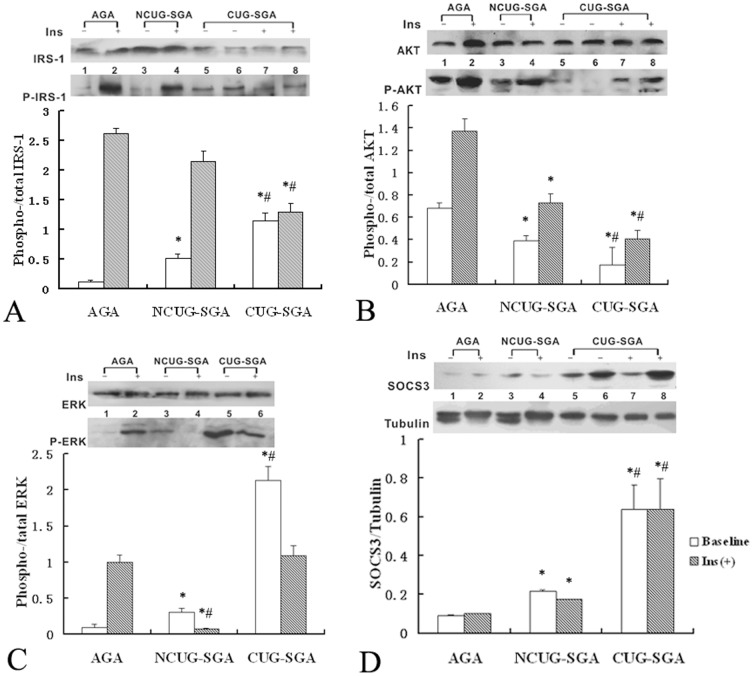
Immunoblot analysis of p-IRS-1, p-AKT, p-ERK and SOCS3 in skeletal muscle cell lysates from CUG-SGA, NCUG-SGA and AGA rats.Rats in appropriate for gestational age (AGA), small for gestational age with catch-up growth (CUG-SGA) and small for gestational age with no catch-up growth (NCUG-SGA) groups (n = 16 for each group) were either intraperitoneal injected intravenously with insulin (Ins) or saline (baseline control) at 4 weeks of age and the skeletal muscles were excised for examination of IRS-1, AKT, ERK, SOCS3 and the phosphorylation of IRS-1, AKT, ERK (p-IRS-1/p-AKT/p-ERK) via Immunoblot analysis. Activation of IRS-1, AKT and ERK were expressed as the ratio of p-IRS-1/p-AKT/p-ERK to total IRS-1, AKT and ERK, respectively. The level of SOCS3 was expressed as the ratio of SOCS3 to tubulin. Data were quantified from 16 samples and were presented as the mean ± SD. *P<0.05 CUG-SGA or NCUG-SGA vs AGA; #
P<0.05 CUG-SGA vs NCUG-SGA.